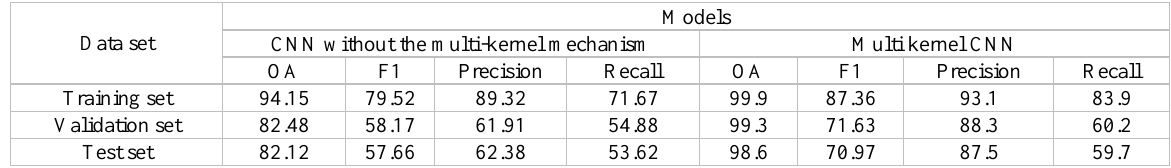
Table2 . The model demonstrated highly accurate predictions of pixels' states when tested on validation and